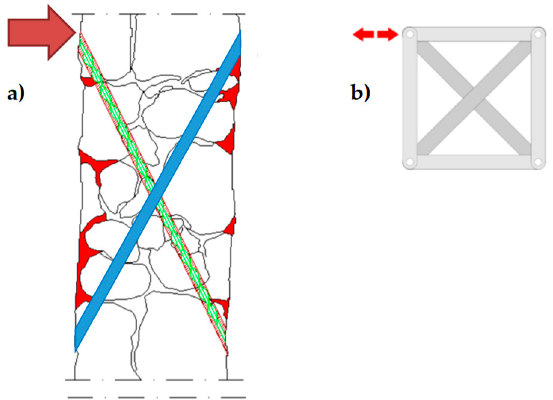
Figure 15. Optimized arrangement of straps to counteract the out-of-plane loads: ( a ) the ribbons of the two staggered meshes pass through the wall along inclined perforations with opposite slopes (positive slopes for the mesh drawn in blue, negative slopes for the mesh drawn in green). ( b ) The inclined ribbons act on the nodes of the CAM system as a cross-bracing act on the nodes of a rectangular frame structure with hinged nodes.